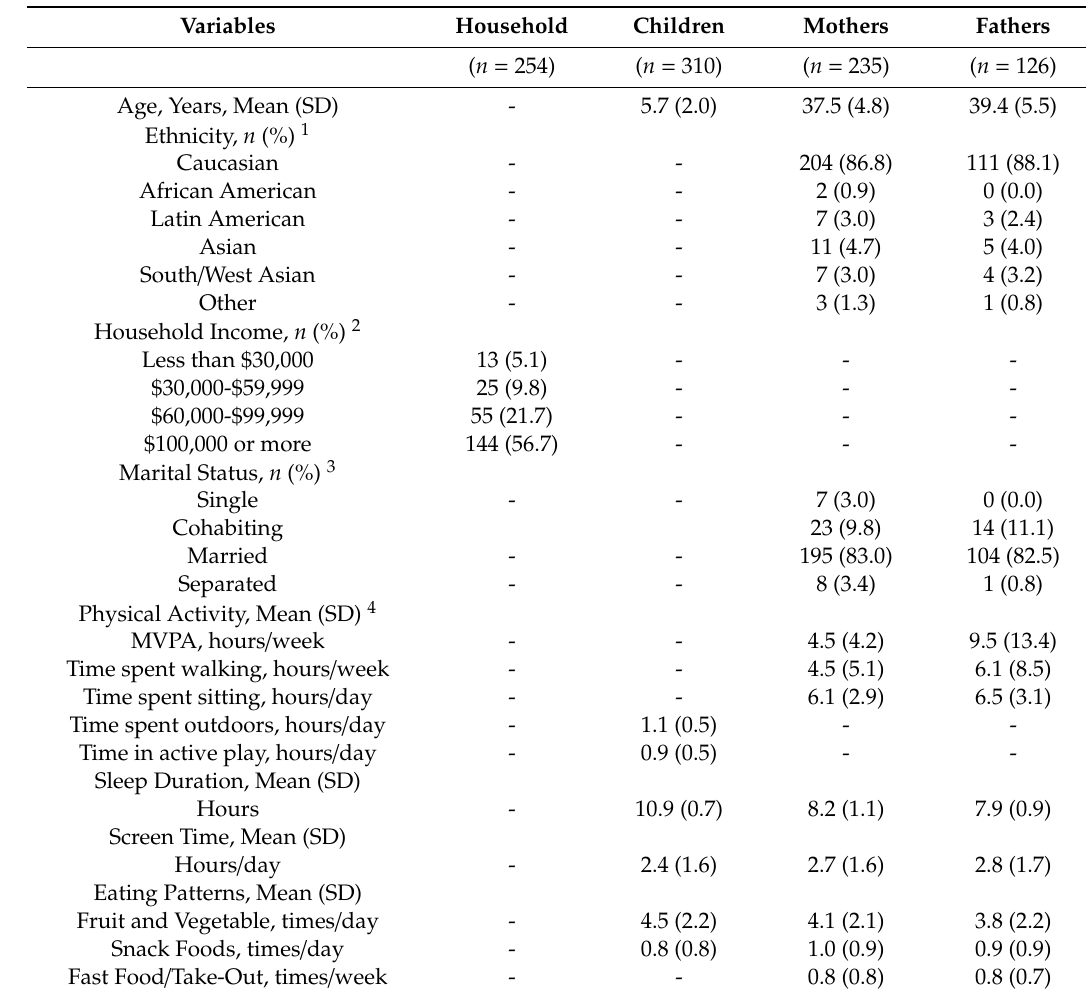
Table 1. Demographics and current health behaviors among families ( n =